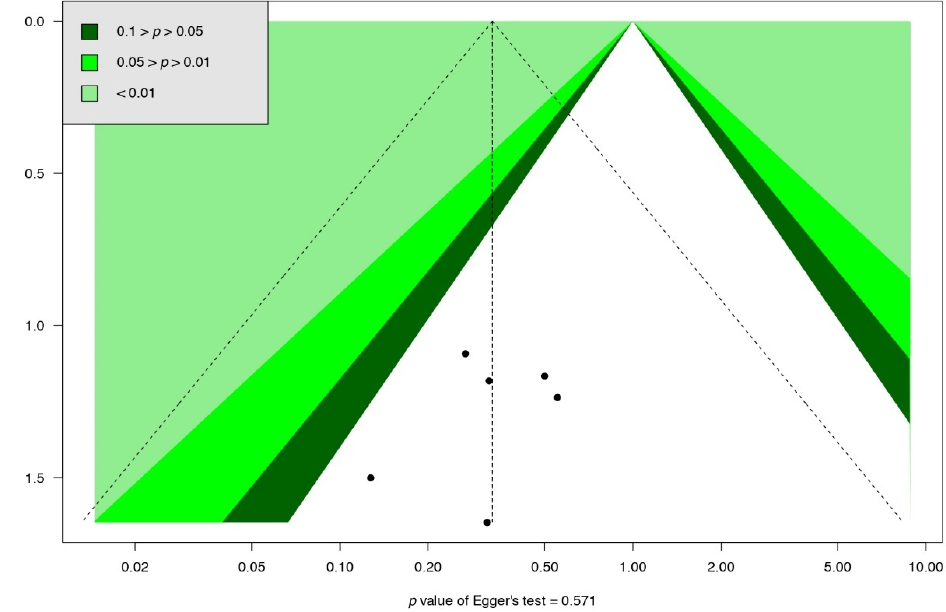
Figure A43. Comparison-adjusted funnel plot in outcome for required blood transfusion.